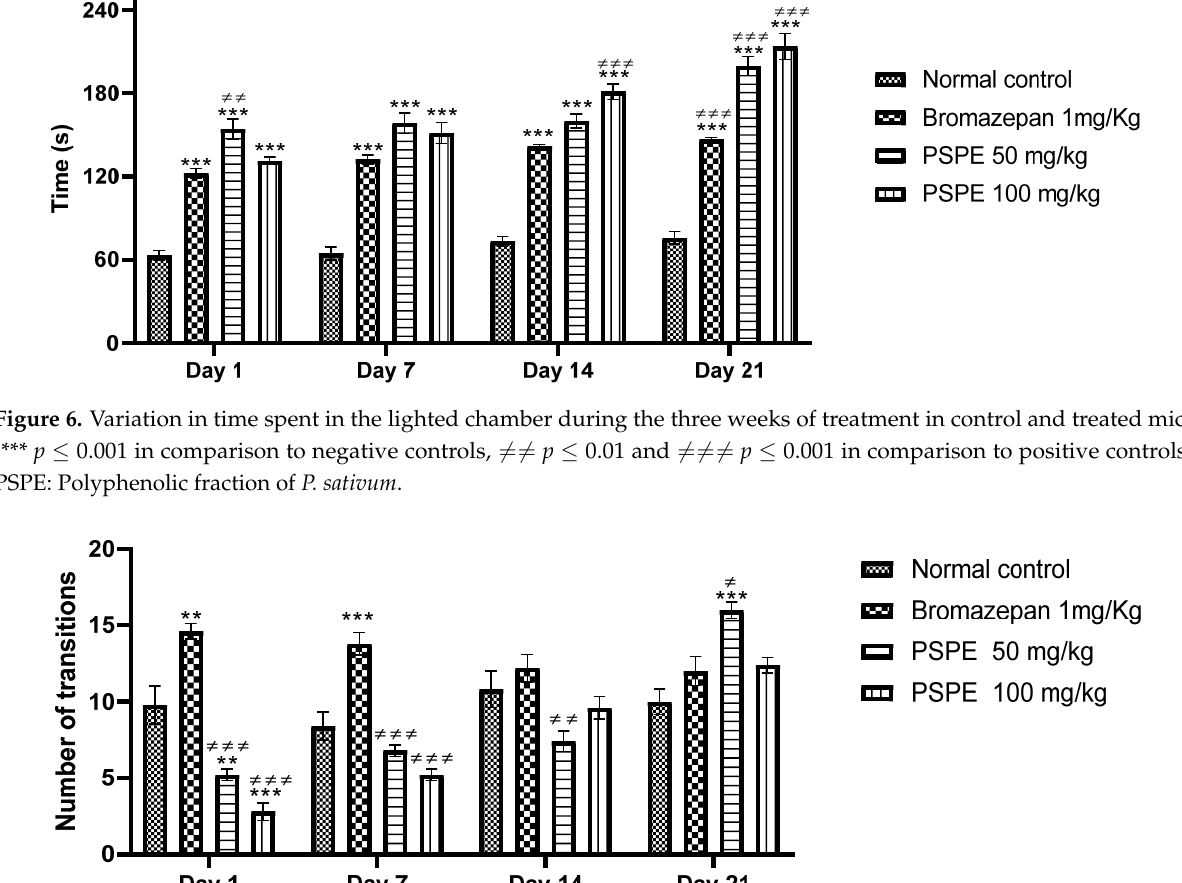
Figure 7. Variation in the number of transitions during the four weeks of treatment in control and treated mice (** p ≤ 0.01 and *** p ≤ 0.001 in comparison to negative controls, ≠ p ≤ 0.05, ≠≠ p ≤ 0.01 and ≠≠≠ p ≤ 0.001 in comparison to positive controls). PSPE: Polyphenolic fraction of P. sativum.